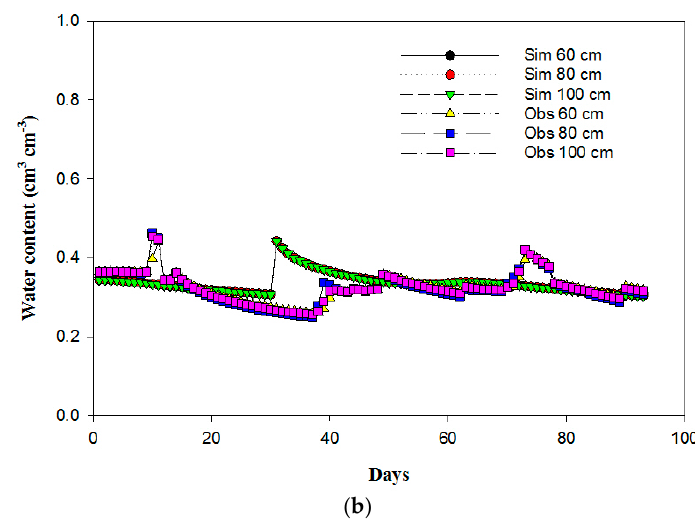
Figure 5. Simulated and observed soil water content below root zone (60–100 cm) during the ( a ) off-season and ( b ) main season.